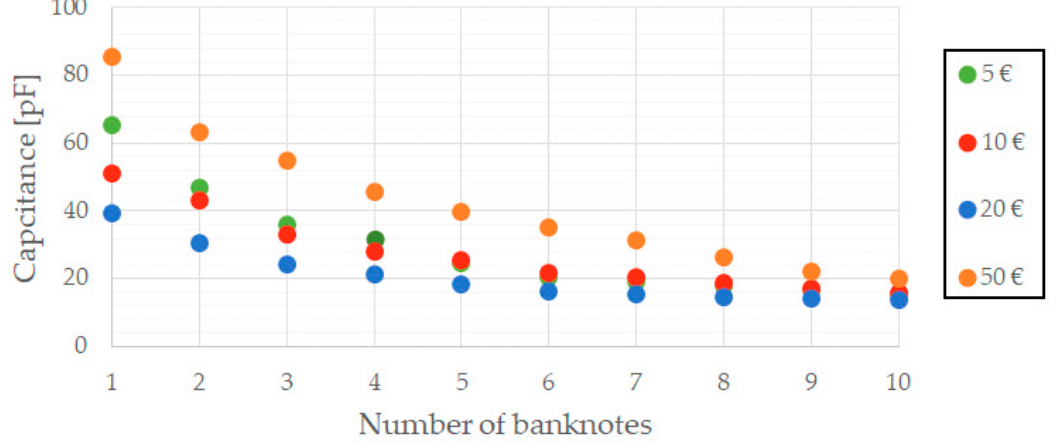
Figure 6. Evolution of the capacitance depending on the banknote value.